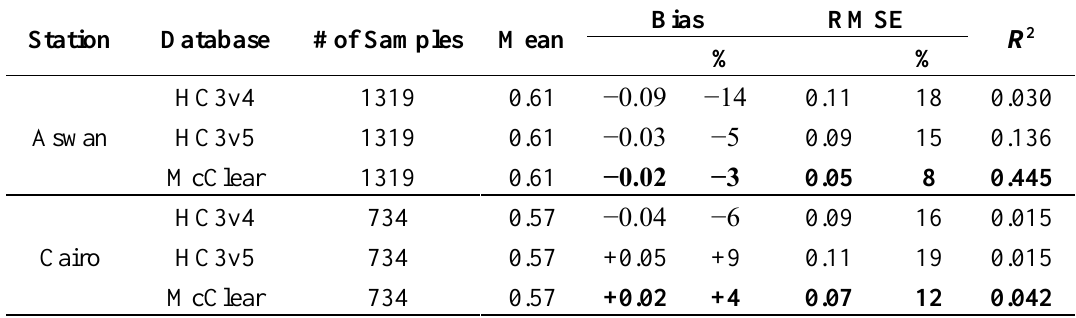
Table 5. Validation of the direct normal clearness index KT Bn under cloud-free conditions, the best values for each station are in bold.